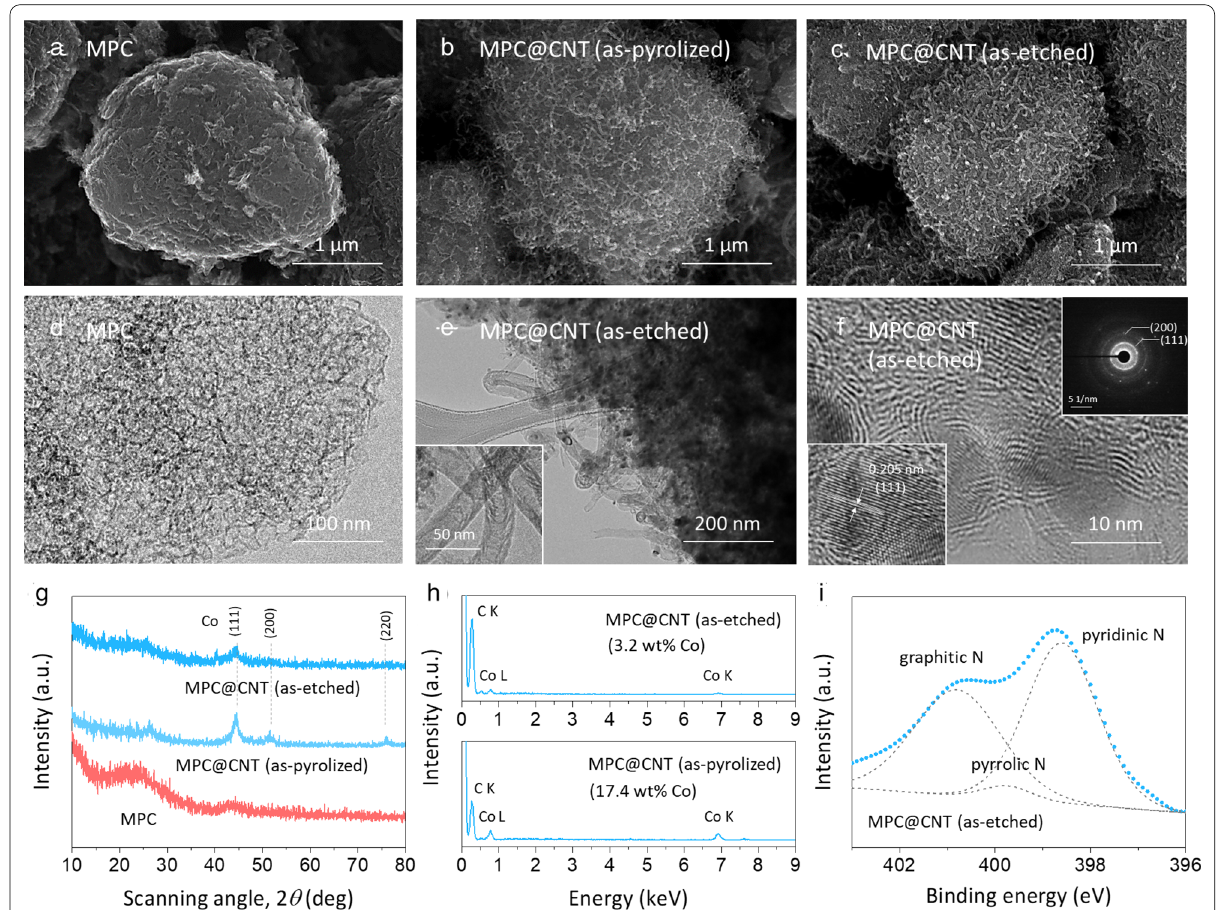
Fig. 2 SEM images of a MPC, b as‑pyrolized MPC@CNT, and c as‑etched MPC@CNT. TEM images of d MPC and e, f as‑etched MPC@CNT. The SAED pattern is shown in the inset of f . g XRD and h EDS of the synthesized samples. i XPS N 1 s spectrum for